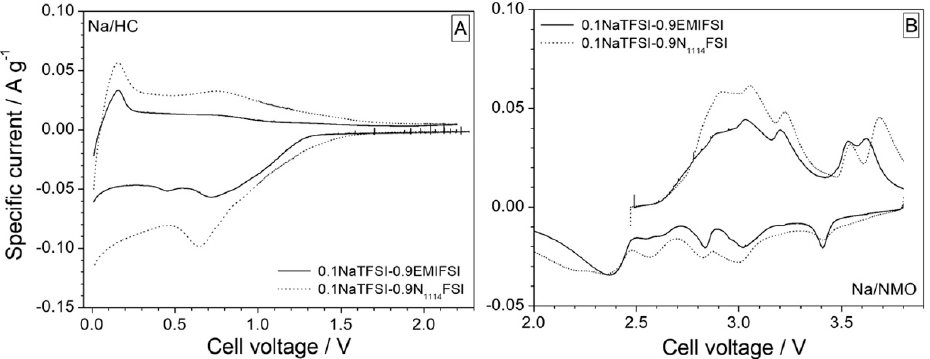
Figure 5. Current-voltage profile related to the 1st CV cycle of Na/HC (panel ( A )) and Na/NMO (panel ( B )) cells containing the 0.1NaTFSI-0.9EMIFSI (solid traces) and 0.1NaTFSI-0.9N 1114 FSI (dotted traces) electrolytes. Scan rate: 0.05 mV s − 1 . Temperature: 20 ◦ C. The voltage values are referred to the Na + /Na ◦ redox couple.